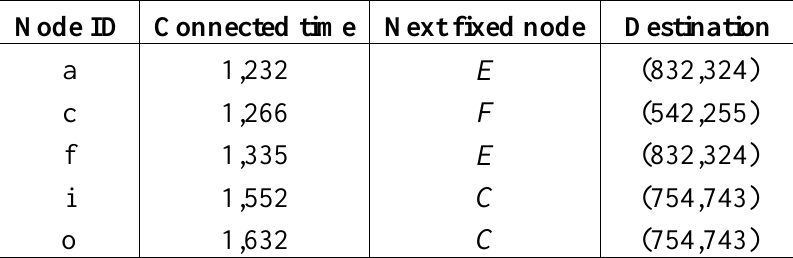
Table 1. Information of mobile nodes held by a fixed node.